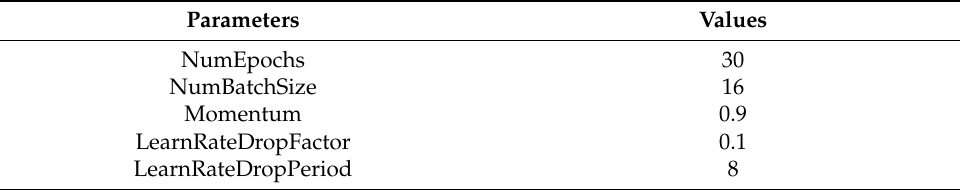
Table 4. Training parameters.